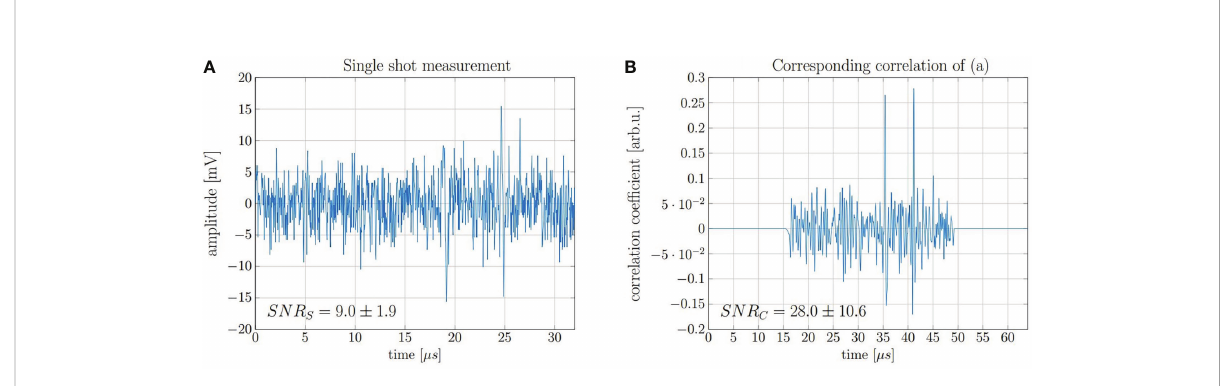
FIGURE 10 (A) Measurement of a single 130 ns pulse with high beam current and a dose deposition corresponding to 0.5 Gy and (B) the corresponding correlation